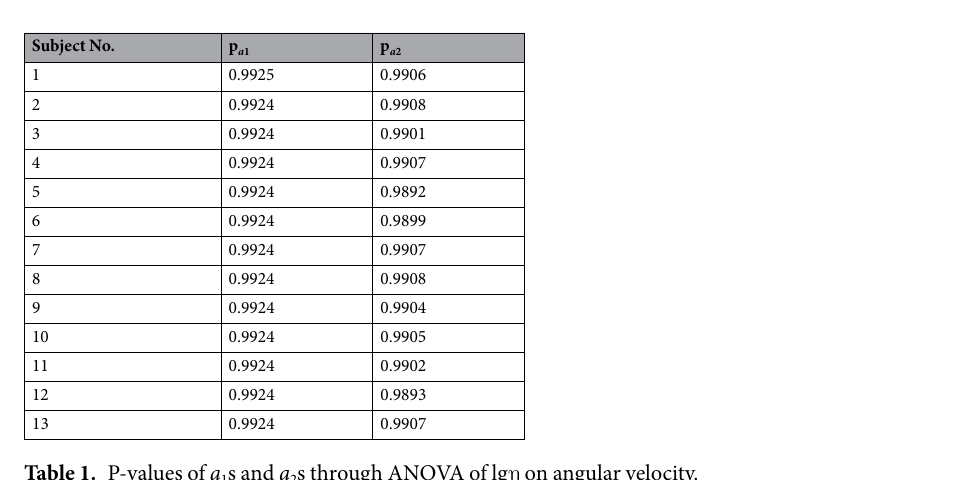
Table 1. P-values of a 1 s and a 2 s through ANOVA of lg η on angular